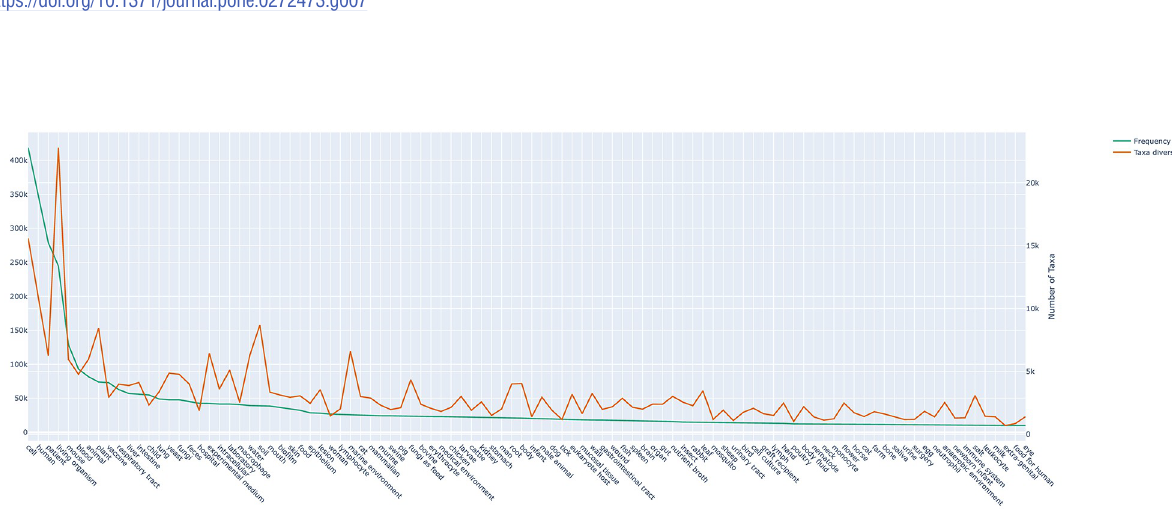
Fig 8. Frequency of habitats and number of different taxa to which they are linked. The green line (left scale) represents the number of Lives_In relations extracted from PubMed that involves each of the 100 most frequent habitats. The brown line (right scale) represents the number of distinct taxa to which each habitat is linked with Lives_In relations extracted from